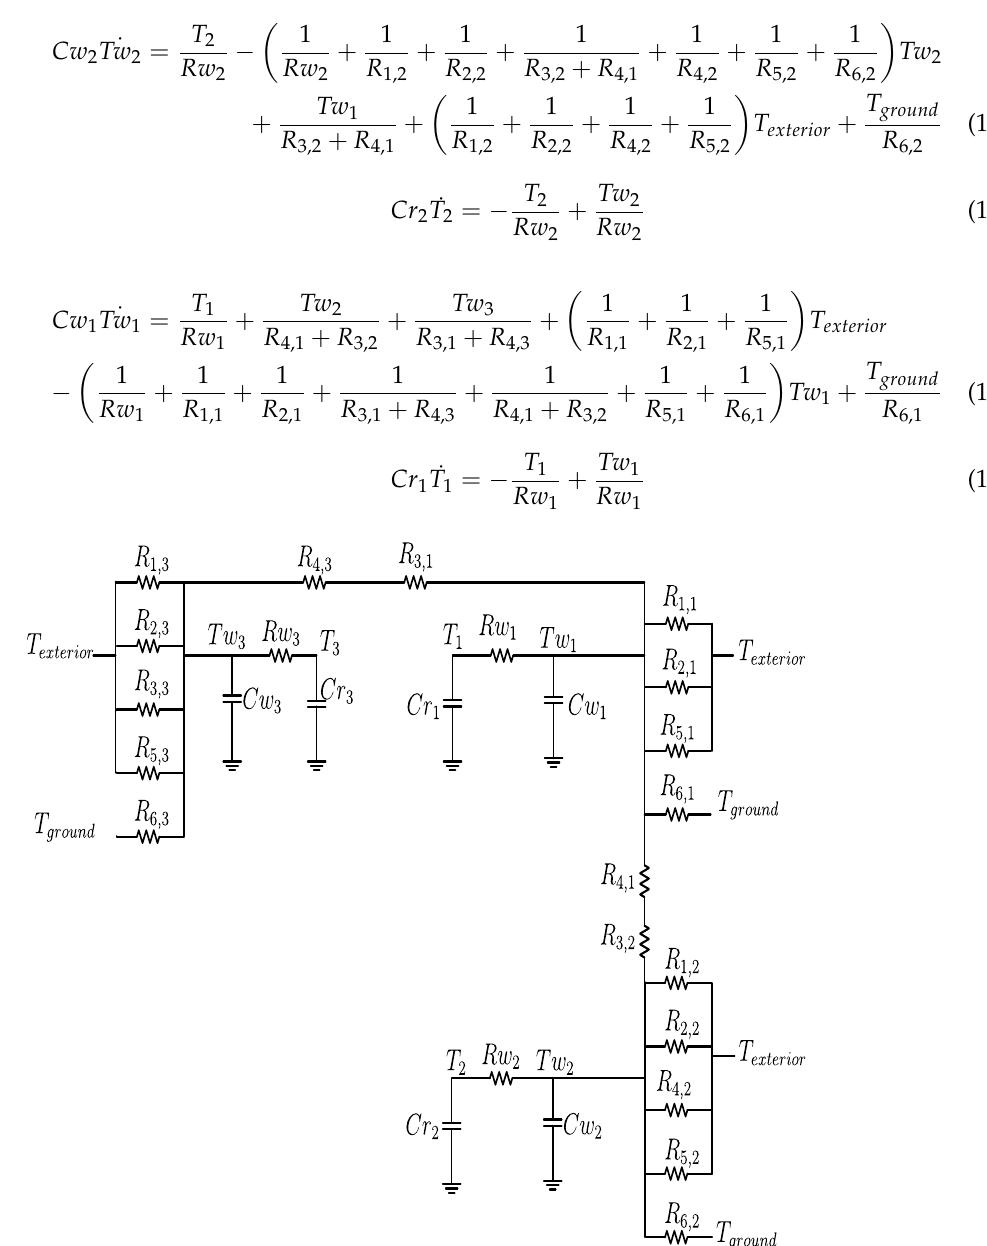
Figure 7. Circuit for a thermal zone with three